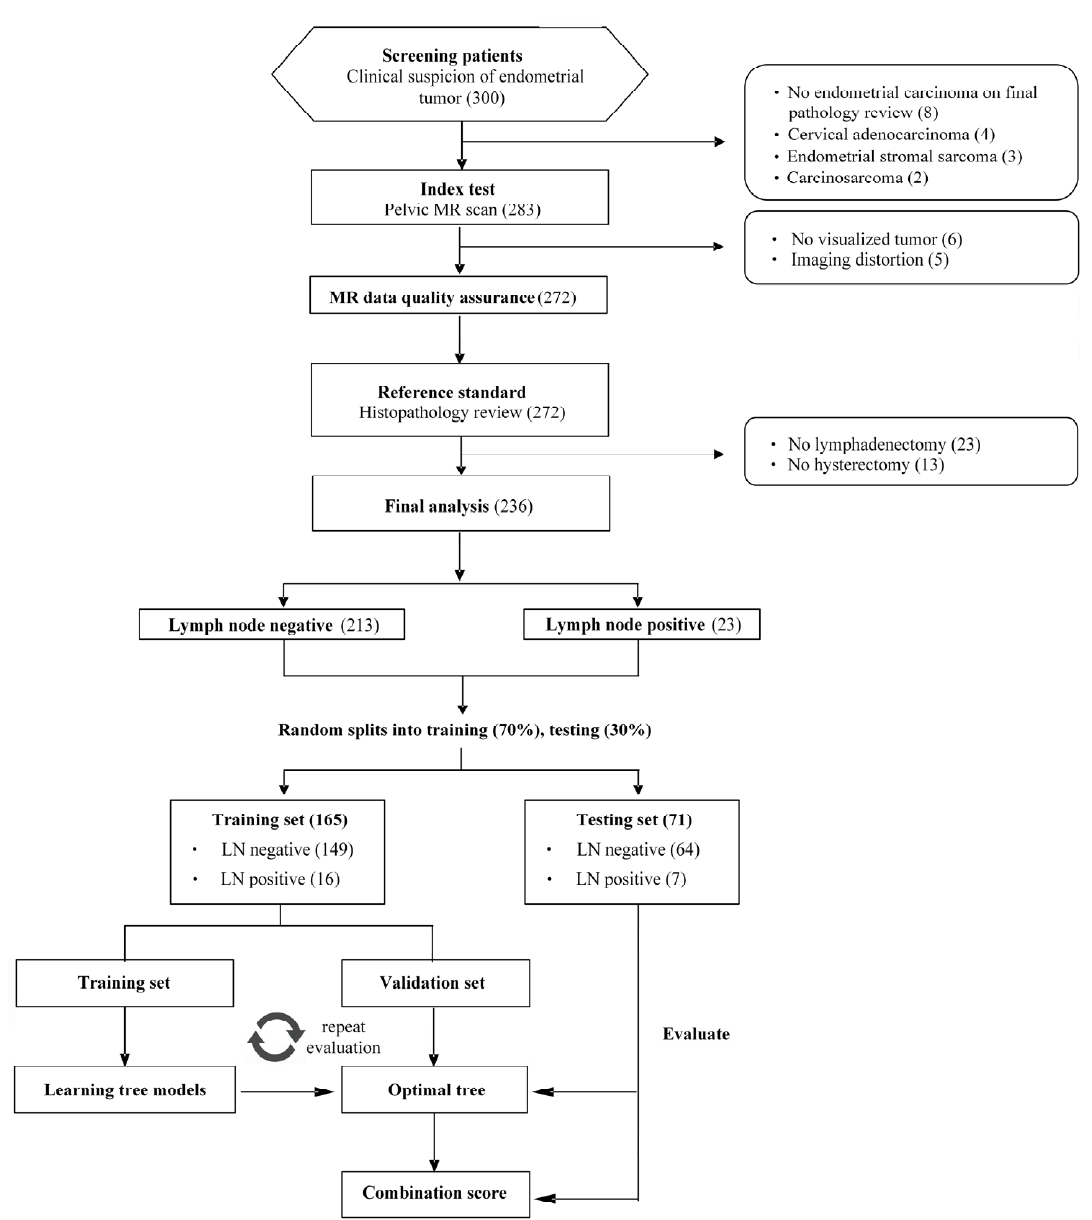
Figure 1. Flowchart of study population. TP = true positive, TN = true negative, FP = false positive, FN = false negative.